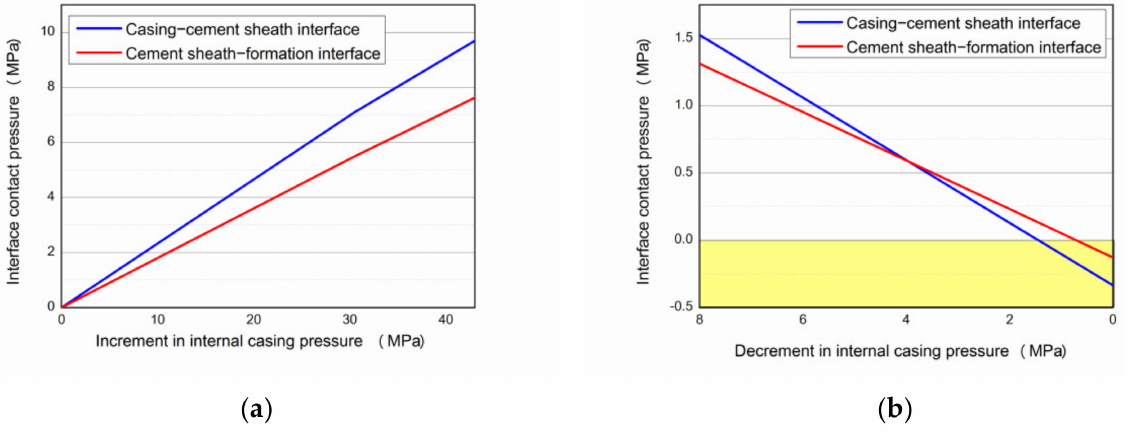
Figure 13. Contact pressure of wellbore cement sheath interface determined without considering the differential temperature stress. ( a ) Acid fracturing stage; ( b ) End of acid fracturing (unloading